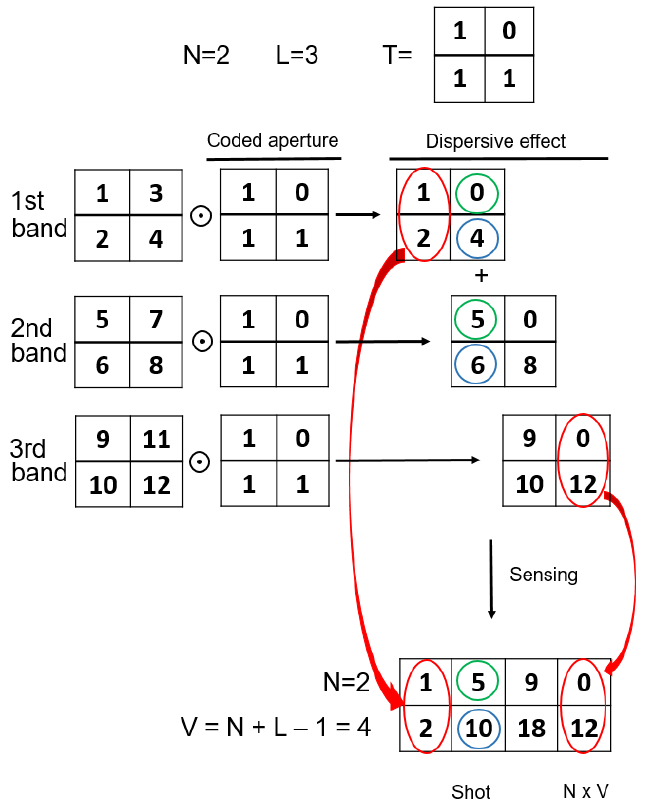
Figure 2. A simple example of the CASSI sensing procedure with N = 2 and L = 3.